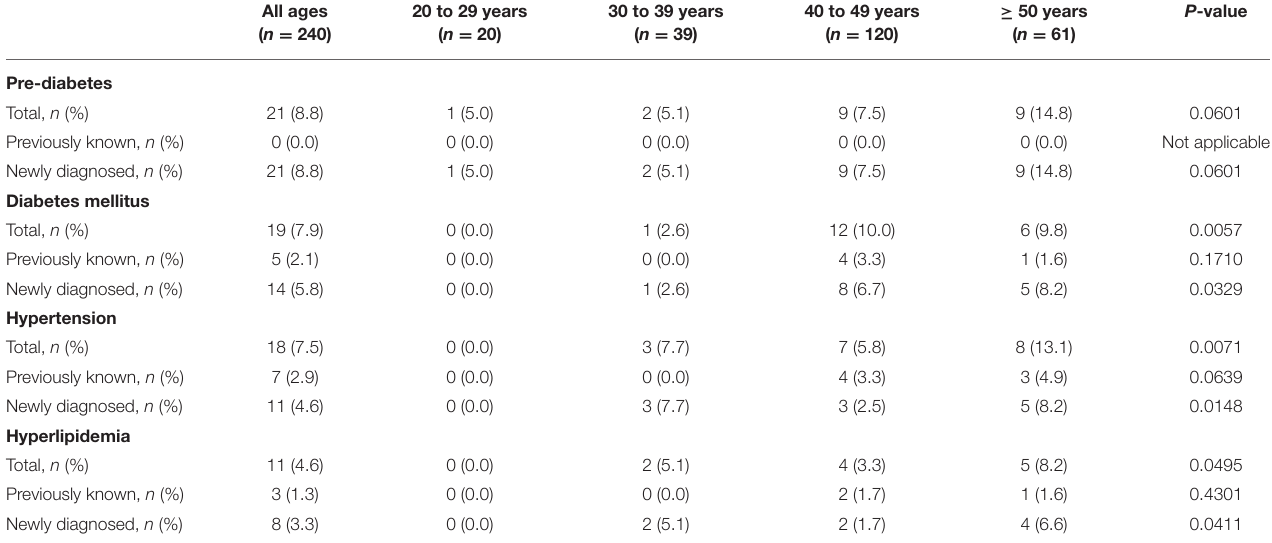
TABLE 6 | Prevalence of chronic